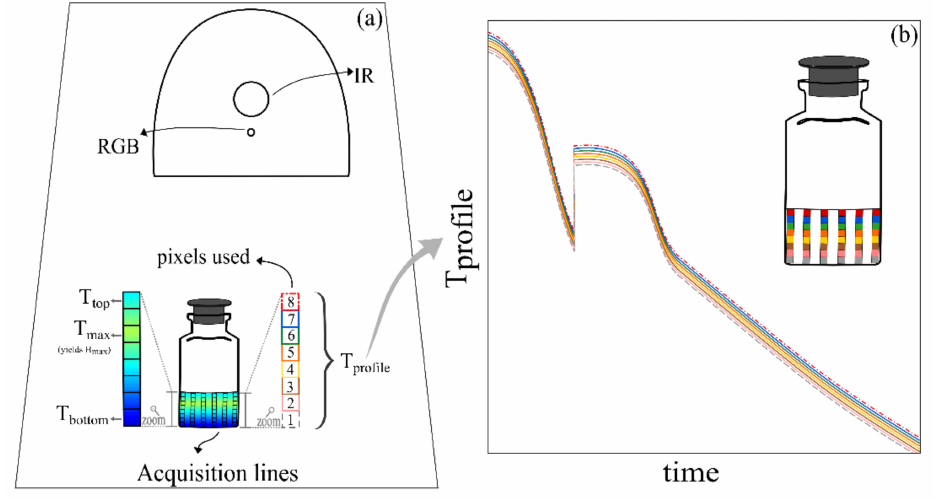
Figure 2. Data acquisition scheme. ( a ) Acquisition lines and pixel resolution used to obtain the IR-based thermal measurements. The colours and line types used as described in this figure by “pixels used” are consistently used to represent data acquired from those pixel positions throughout the paper when applicable. The colour gradient in the vial represents the thermal gradient detected by the camera and expresses the detection and definition of the T max and H max . ( b ) a representation of the T profile that would be obtained from a vial with an arbitrary consistent thermal gradient, increasing from bottom to